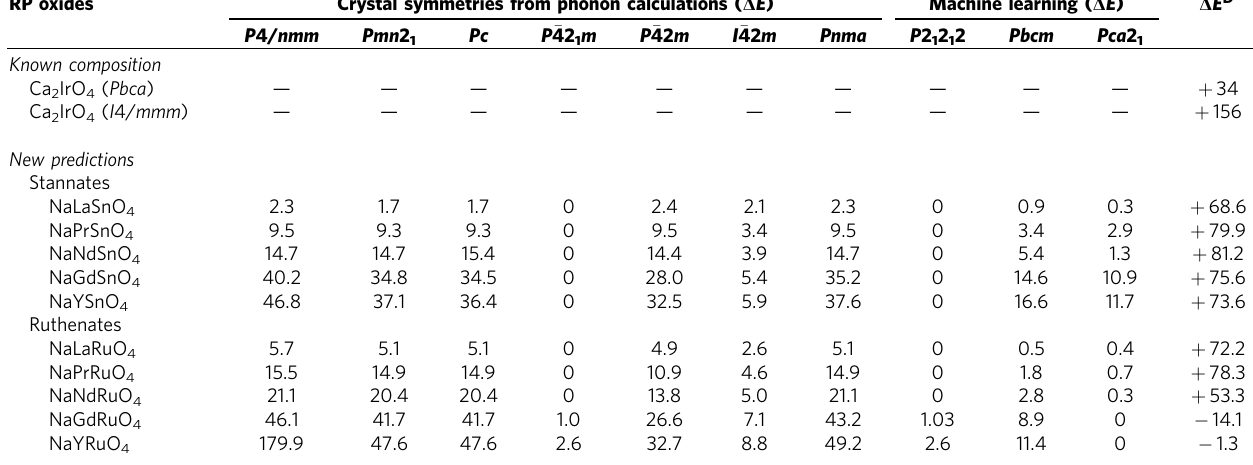
Table 4 | The total energy difference and thermodynamic stability for different known and predicted RP phases from Quantum ESPRESSO 63